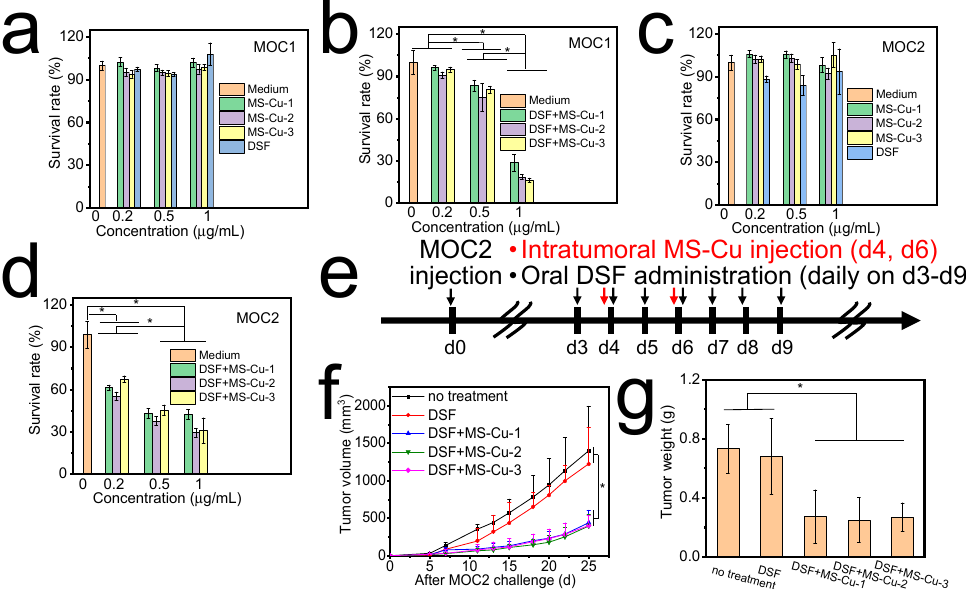
Figure 3. Cytotoxicity of only MS-Cu nanospheres ( a , c ), only DSF ( a , c ), and combination of MS-Cu nanospheres and DSF ( b , d )against MOC1 ( a , b ) and MOC2 ( c , d ) cells in vitro. In vivo antitumor efficacy of combined oral administration of DSF and intratumoral administration of MS-Cu nanospheres. Experimental protocol ( e ), tumor volume ( f ), and tumor weight at the endpoint ( g ) (*, p < 0.05).